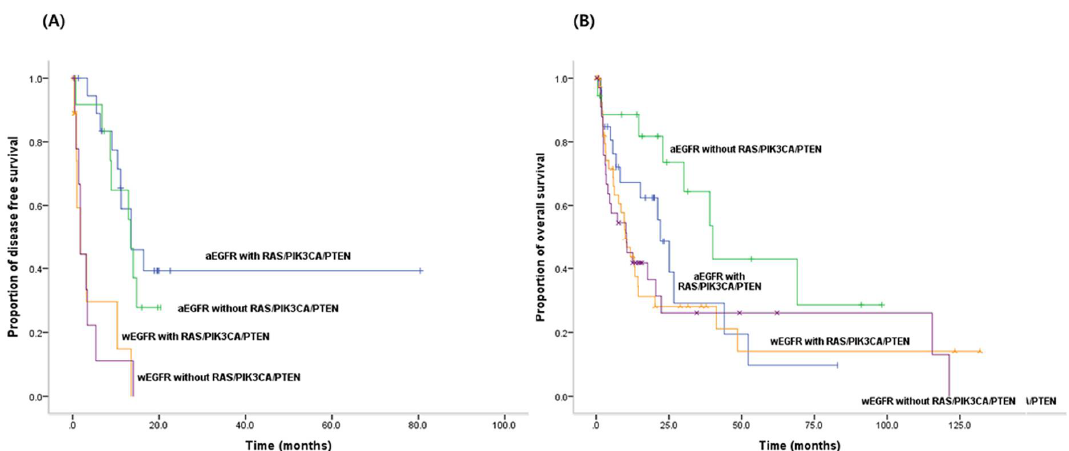
Figure 3. Kaplan–Meier estimates of ( A ) progression free survival (aEGFR vs. wEGFR, p < 0.001): patients with activating EGFR mutations had a better PFS for EGFR-TKIs than patients with wild-type EGFR, regardless of the presence or absence of any of RAS / PIK3CA / PTEN mutations, and ( B ) overall survival (aEGFR vs. wEGFR, p = 0.022) according to comprehensive EGFR activating mutational status or RAS / PIK3CA / PTEN mutations in NSCLC patients. Morevover, patients with activating EGFR mutations had a better OS than patients with wild-type EGFR, regardless of the presence or absence of any RAS / PIK3CA / PTEN